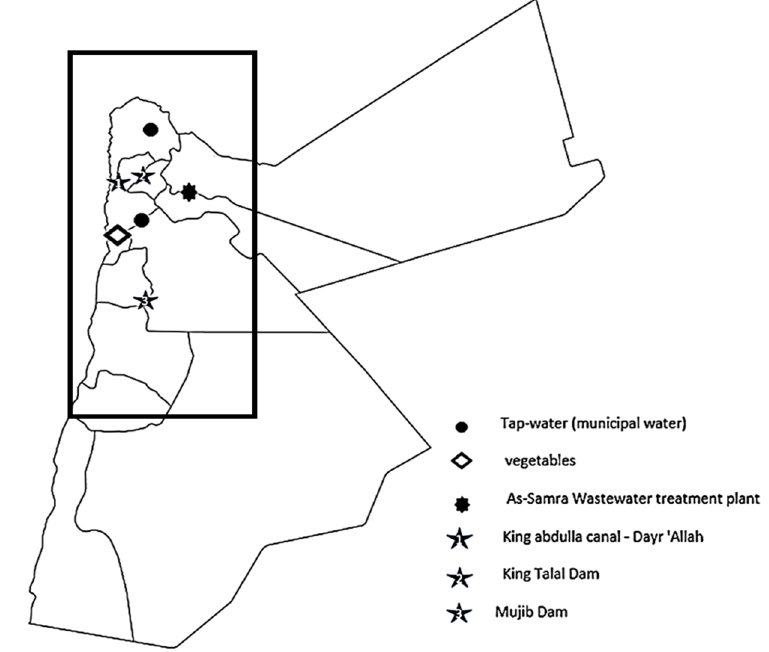
Figure 2. The distribution of sample collection sites.